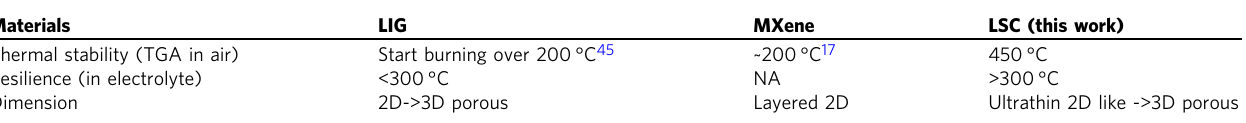
Materials LIG MXene LSC (this work) Thermal stability (TGA in air) Start burning over 200 °C 45 ~200 °C 17 450 °C Resilience (in electrolyte) <300 °C NA >300 °C Dimension 2D->3D porous Layered 2D Ultrathin 2D like ->3D porous